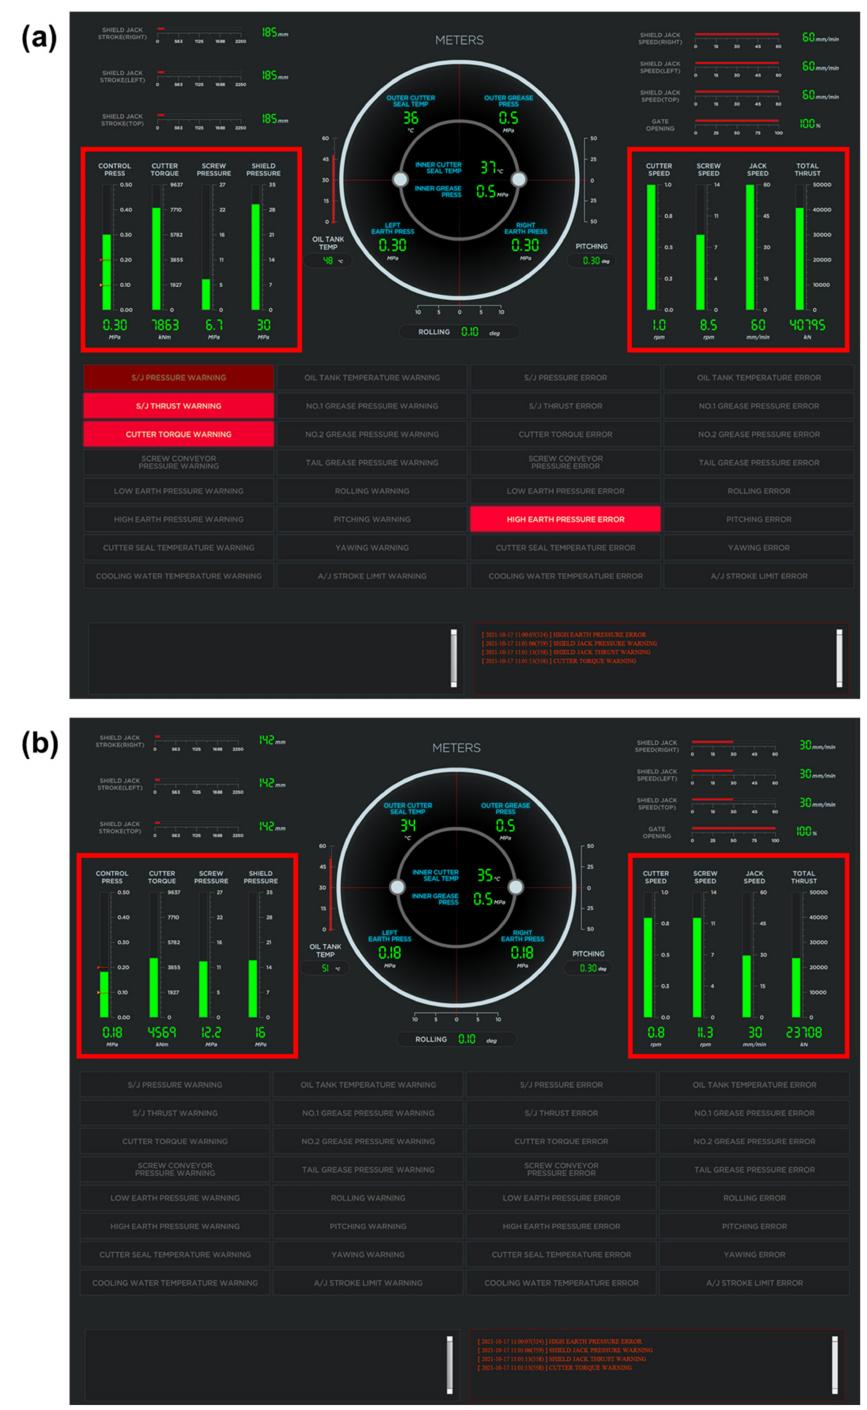
Figure 14. Simulation test results: ( a ) caused by adjustments of cutterhead rotation, shield jack, and screw conveyor rotation speeds; ( b ) resolved by adjustments of cutterhead rotation, shield jack, and screw conveyor rotation